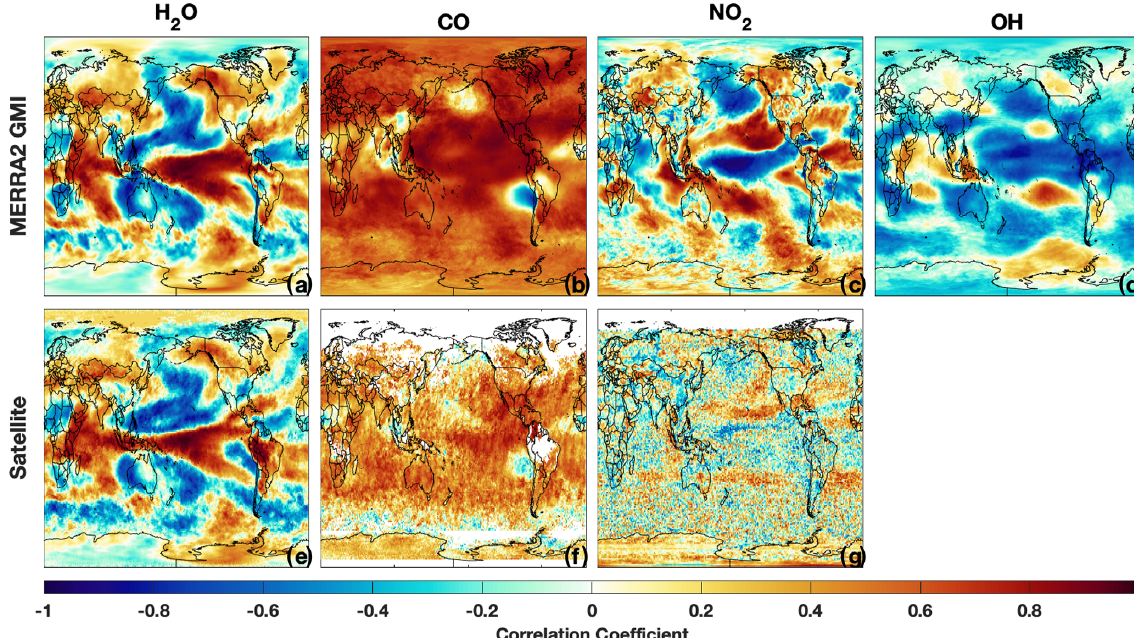
Figure 9. Regression of tropospheric column H 2 O ( v ) (a) , CO (b) , NO 2 (c) , and OH (d) from MERRA-2 GMI (top) and satellite retrievals from AIRS (e) , MOPITT (f) , and OMI (g) against the MEI for DJF over the satellite lifetime.